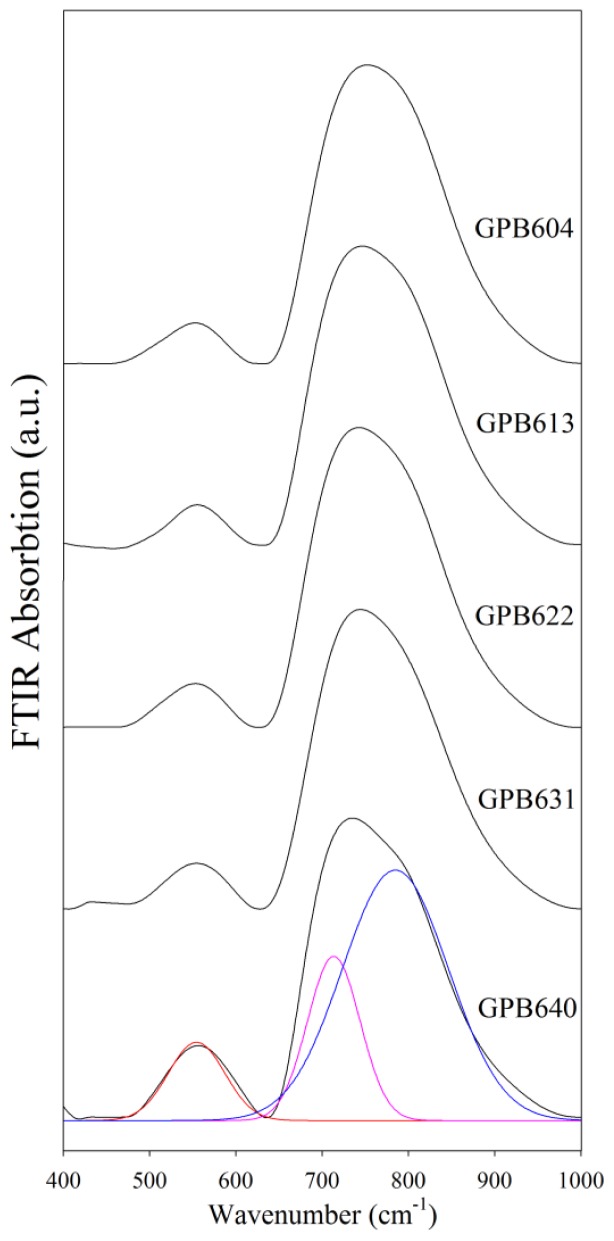
Fourier transform infrared (FTIR) spectrum of (GeO2)0.6(PbO)0.4 −
x(1/2Bi2O3)x glass of different compositions.